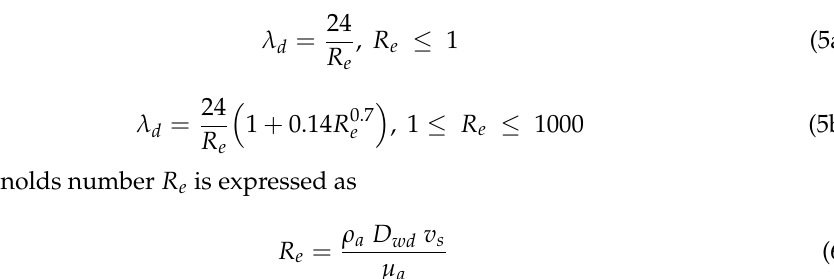
(d) Figure 2. Grid distribution of water droplet and its shape falling in air at 283.15 K, 0.05 s: ( a ) case 1; ( b ) case 2; ( c ) case 3; ( d ) case 4.